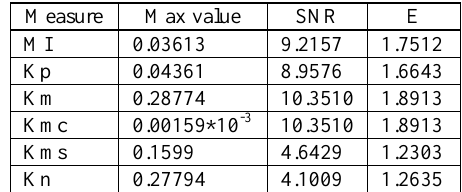
Table 2. Numeric data for TV-IR matching (Example 2).